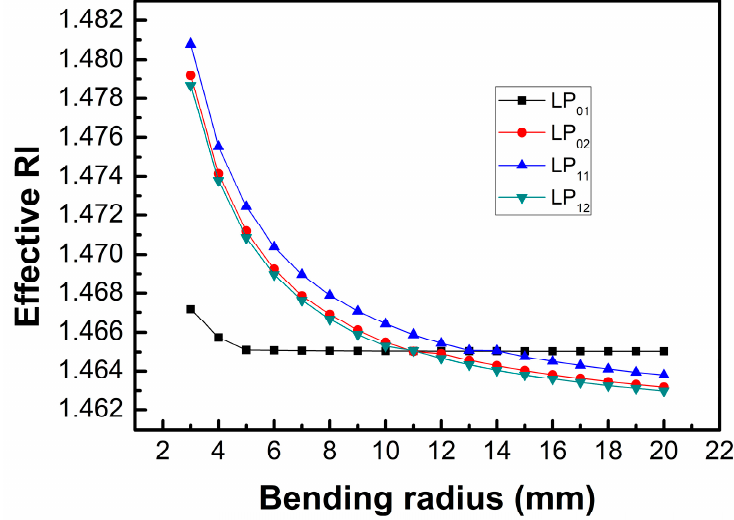
Figure 4. The effective RIs of the first two orders of the LP 0n and LP 1n modes with different bending radii.